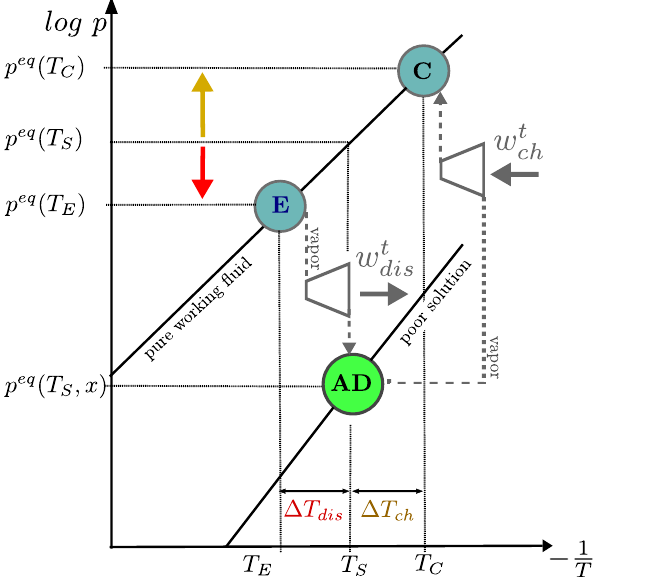
Figure 6. Influence of driving temperatures on usable/required pressure ratio in a Van ’t Hoff diagram.